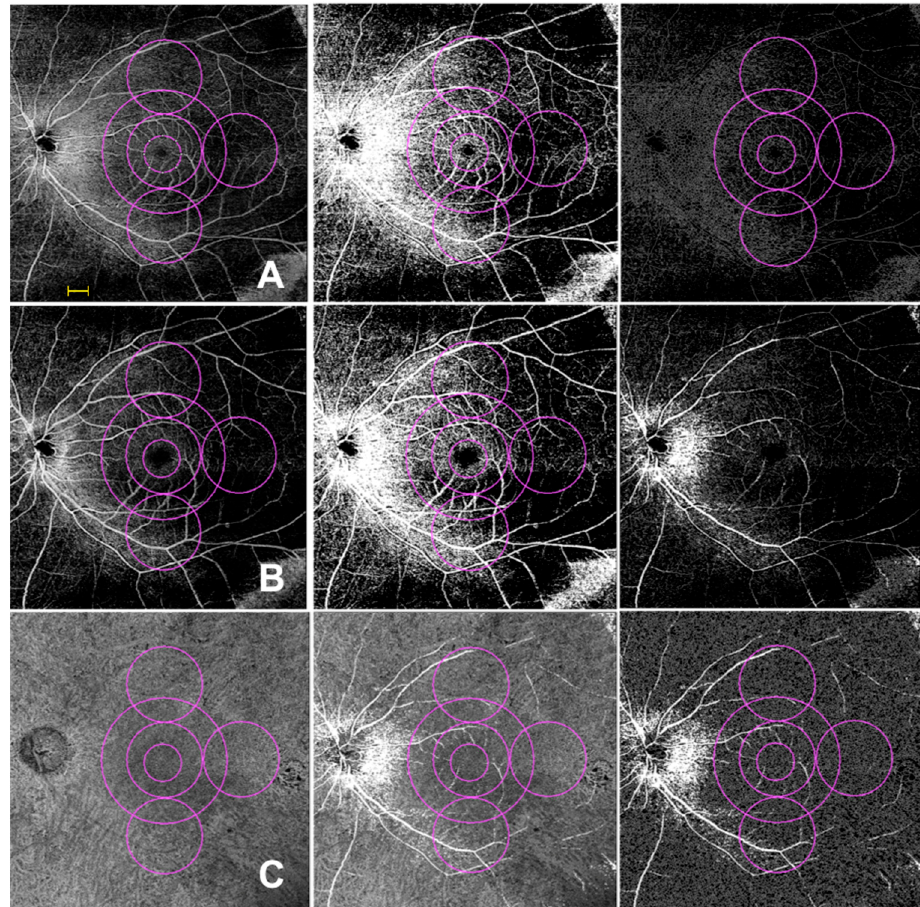
Figure 2. Widefield swept source optical coherence tomography (WSS-OCTA) assessment of superficial capillary plexus (SCP) ( A ). deep capillary plexus (DCP) ( B ) and choriocapillaris (CC) ( C ) in a 12 × 12 mm image of a retinitis pigmentosa (RP) patient; A , B , C (Left images) SCP, DCP and CC were investigated in two different regions: macular region (three concentric pink circles with a diameter of 1.5 mm. 3 mm ad 5 mm); and midperiphery region (three pink circles with diameters of 3 mm tangential to the central circle). The SCP, DCP and CC binarized ( A , B , C middle) and skeletonized ( A , B , C right) images were obtained with ImageJ to investigate perfusion and vessel length density, respectively. The superficial capillary plexus’ big retinal vessels were identified and merged into DCP and CC images and finally excluded from the analysis, thus avoiding shadowing and projection artifacts from SCP. Scale bar = 1 mm.